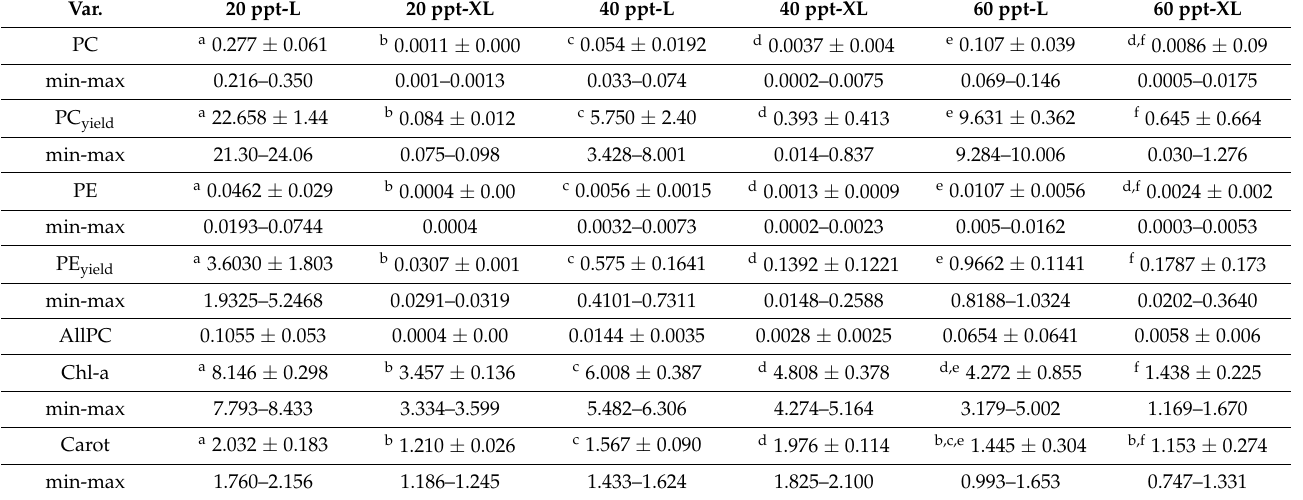
or significant differences, respectively, at a 0.05 level of confidence examined by a pair-wise Tukey’s test.